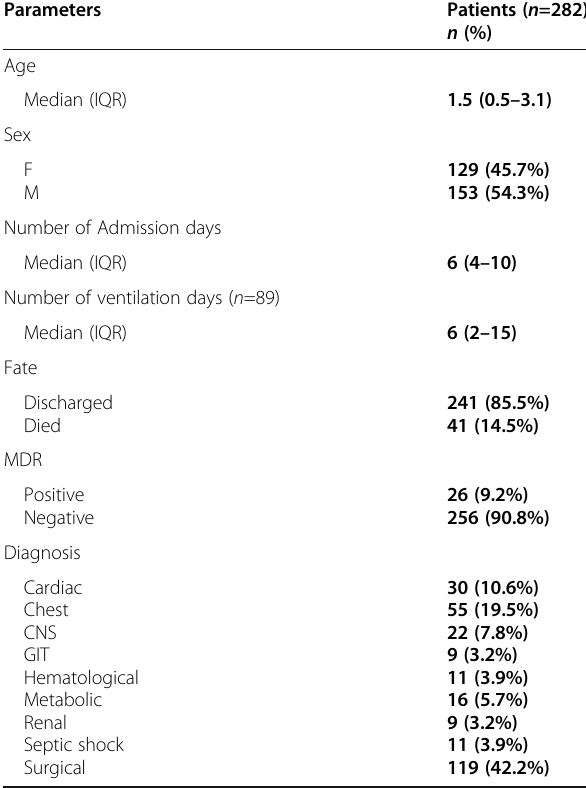
Table 1 Descriptive statistics of demographic and clinical